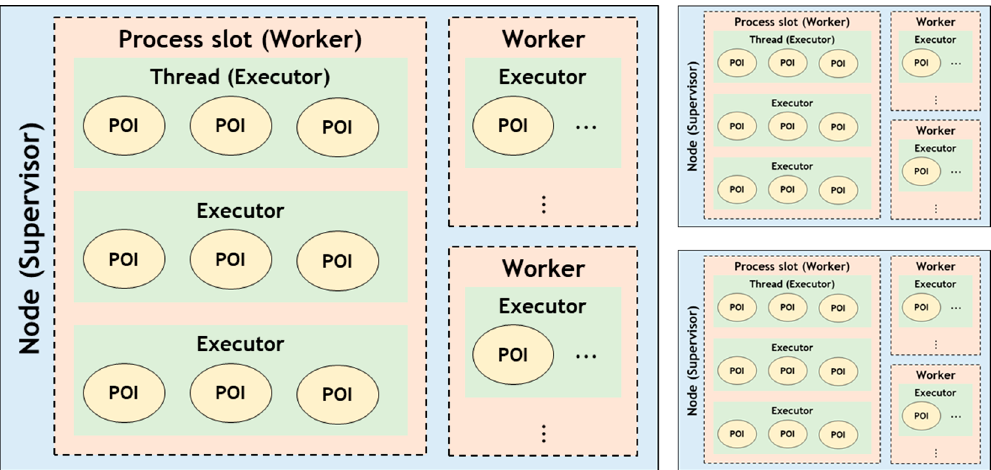
Figure 2. Hierarchy of processing operator instances (POIs) allocated to process slots in Apache Storm.